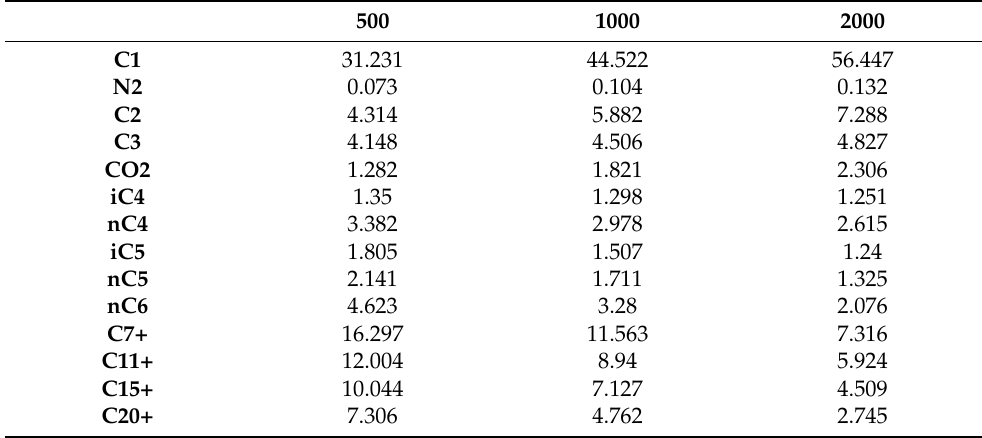
Table 1. PVT data typical of an Eagle Ford well based on gas–oil ratios (scf/bbl) (after Gala and Sharma